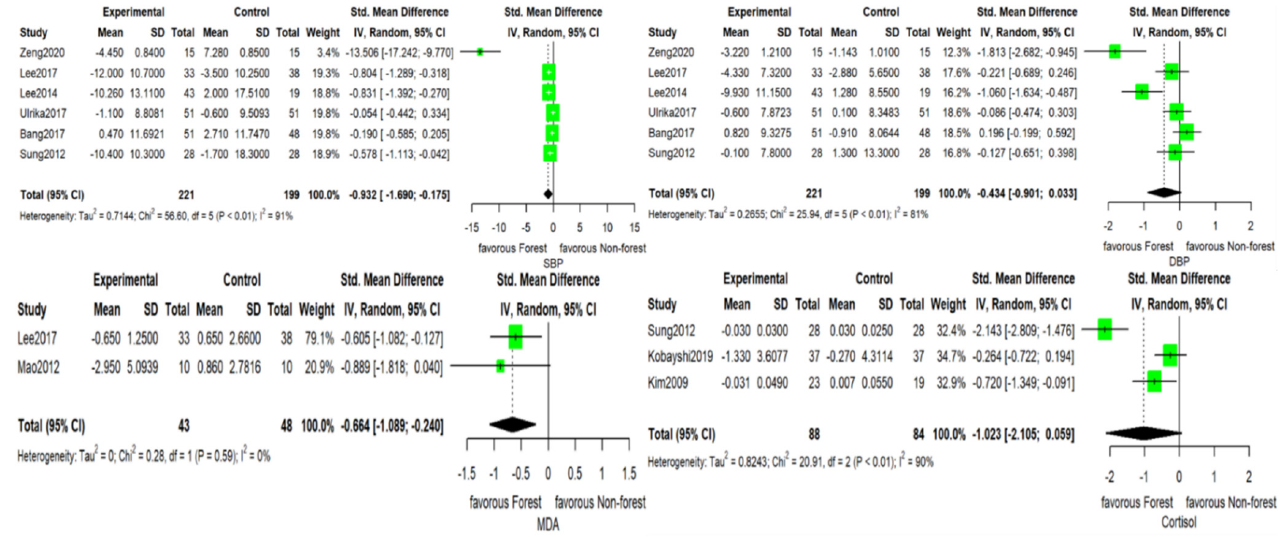
Figure 4. Forest plot of the results of a random-effects meta-analysis shown as mean differences in physiological biomarkers with 95% CIs. CI, confidence interval; SD, standard deviation; SBP, systolic blood pressure; MDA, malondialdehyde; DBP, diastolic blood pressure.